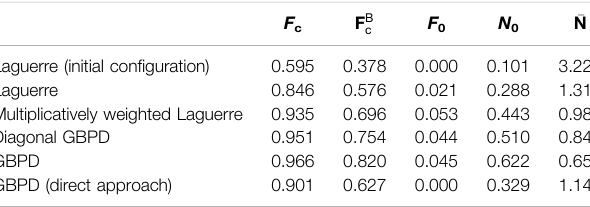
TABLE 4 | Values of performance measures for various tessellation models fi tted to the raw experimental image